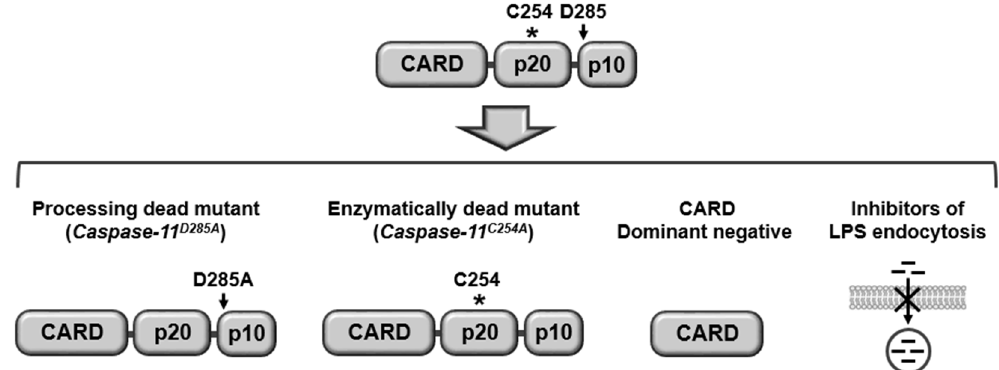
Figure 3. Potential strategies targeting caspase-11 non-canonical inflammasome. Activation of caspase-11 non-canonical inflammasome can be inhibited by generating caspase-11 processing-dead mutant (Caspase-11D285A) and caspase-11 enzymatically-dead mutant (Caspase-11C254A). Also, by preventing the interaction between LPS and caspase-11 using CARD dominant-negative and the LPS internalization via blocking the interaction of LPS with its receptors, such as TLR4 and RAGE. TLR4, Toll-like receptor 4; RAGE, receptor for advanced glycation end-product. *: Caspase-11 enzymatic activity site, arrow: Caspase-11 auto-proteolysis site